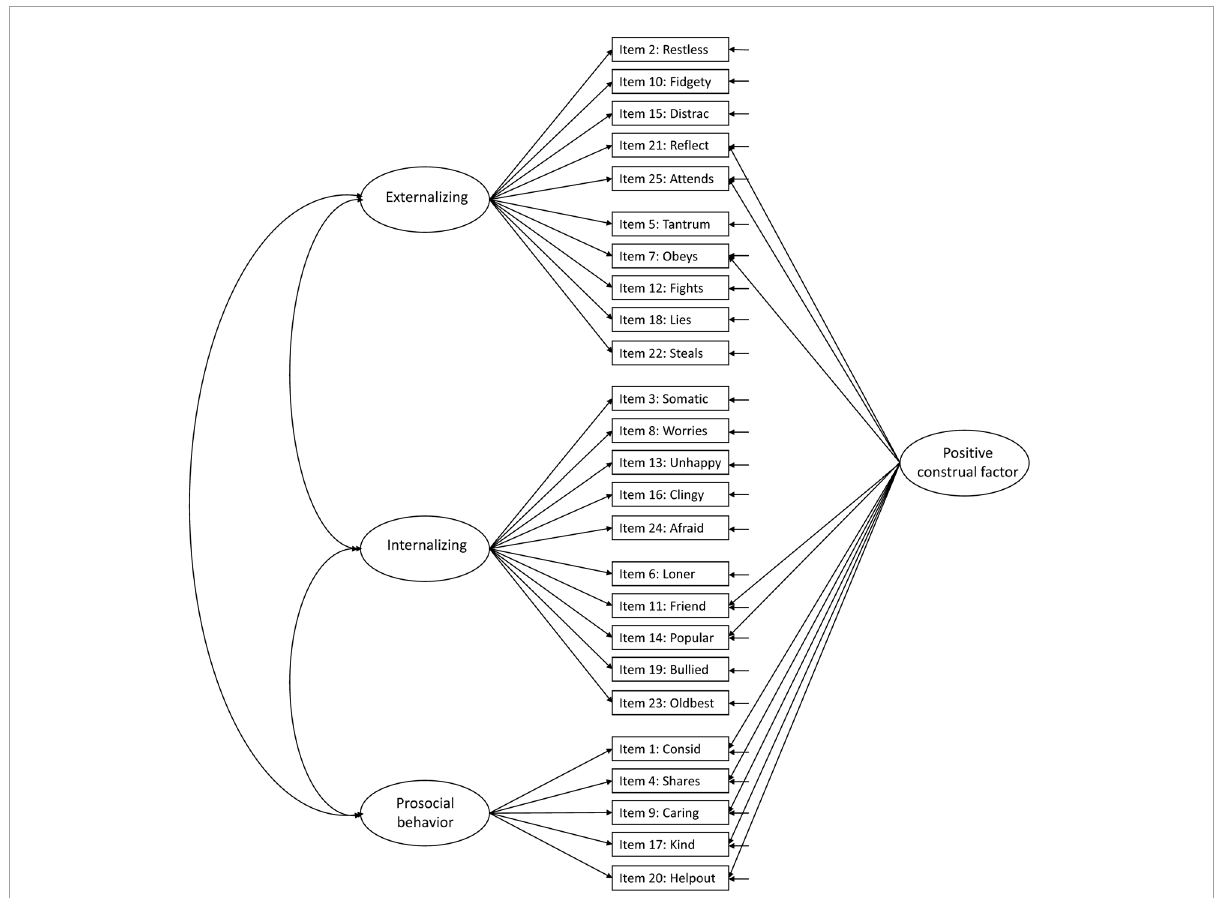
FIGURE6 Three-factor model (internalizing, externalizing, and prosocial behavior) with a positive construal method factor for the positively worded items (Model 6).